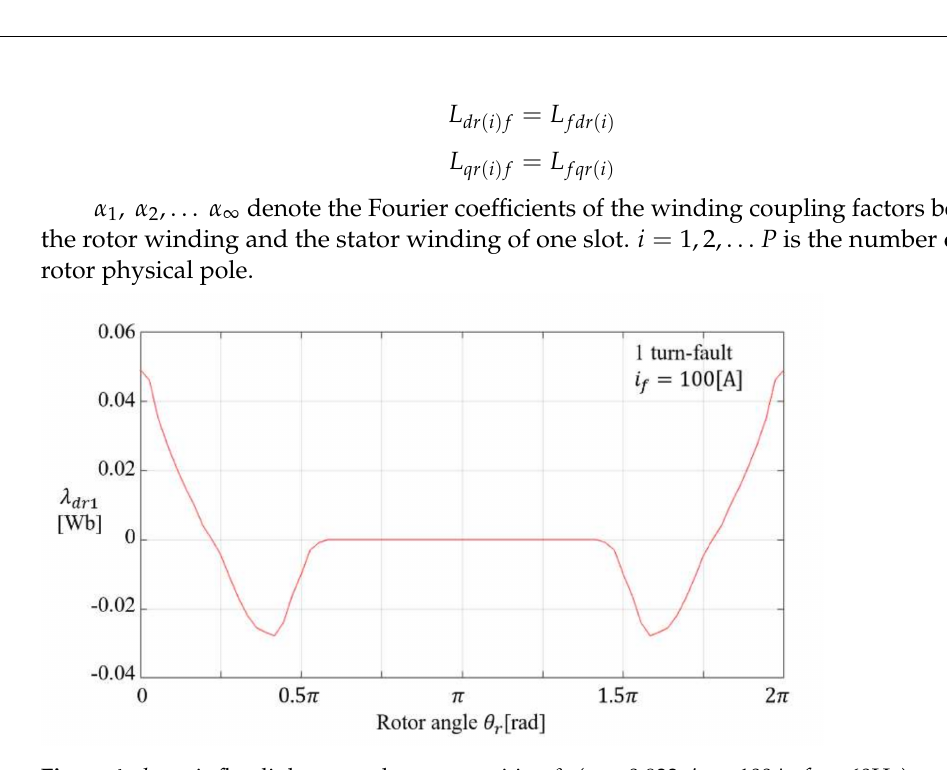
Figure 4. d r 1 -axis flux linkage vs. the rotor position θ r ( x = 0.933, i f = 100A, f r =